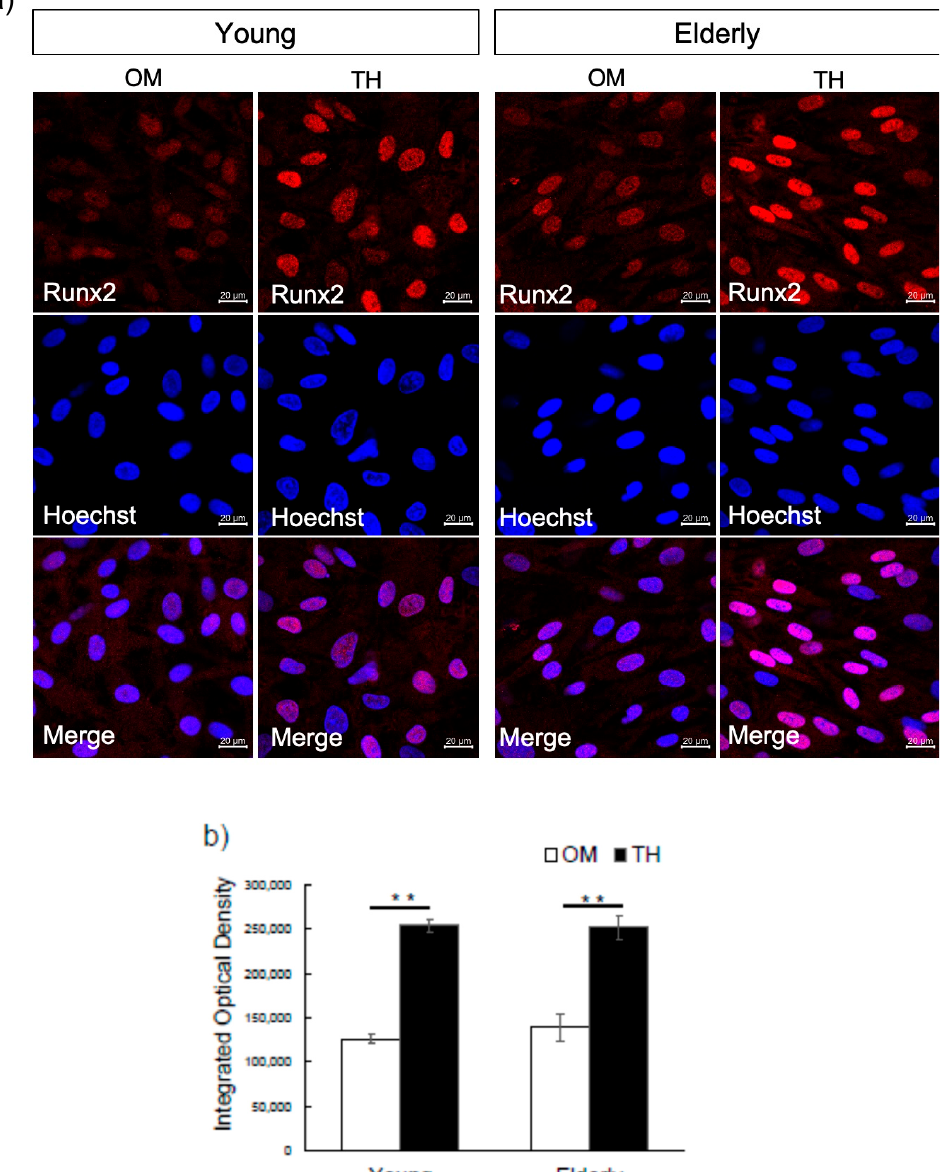
Figure 4. The e ff ect of TH on Runx2 expression of DPSCs from young and elderly patients. ( a ) Young and elderly DPSCs were cultured in OM and OM with TH for 7 days. The cells were stained by antibodies of Runx2. Nuclei were visualized by Hoechst. Original magnification was × 40. Scale bar is 20 µ m. ( b ) Integrated density of nuclei of 30 independent cells in randomly selected field of view was measured. Analysis of fluorescent signal of nuclei of cells treated with TH and OM of three independent experiments was performed. Statistical analysis was performed by Student’s t -test. (** p <